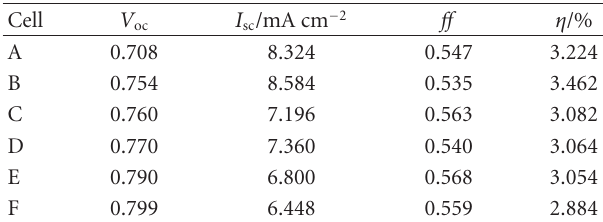
Table 2: Photovoltaic performances of DSSCs with PVDF/IL-SiO 2 (1/1) GPEs.